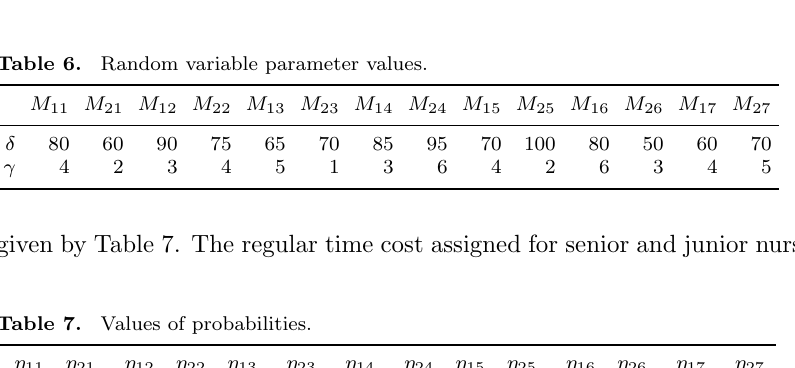
Table 6. Random variable parameter values.